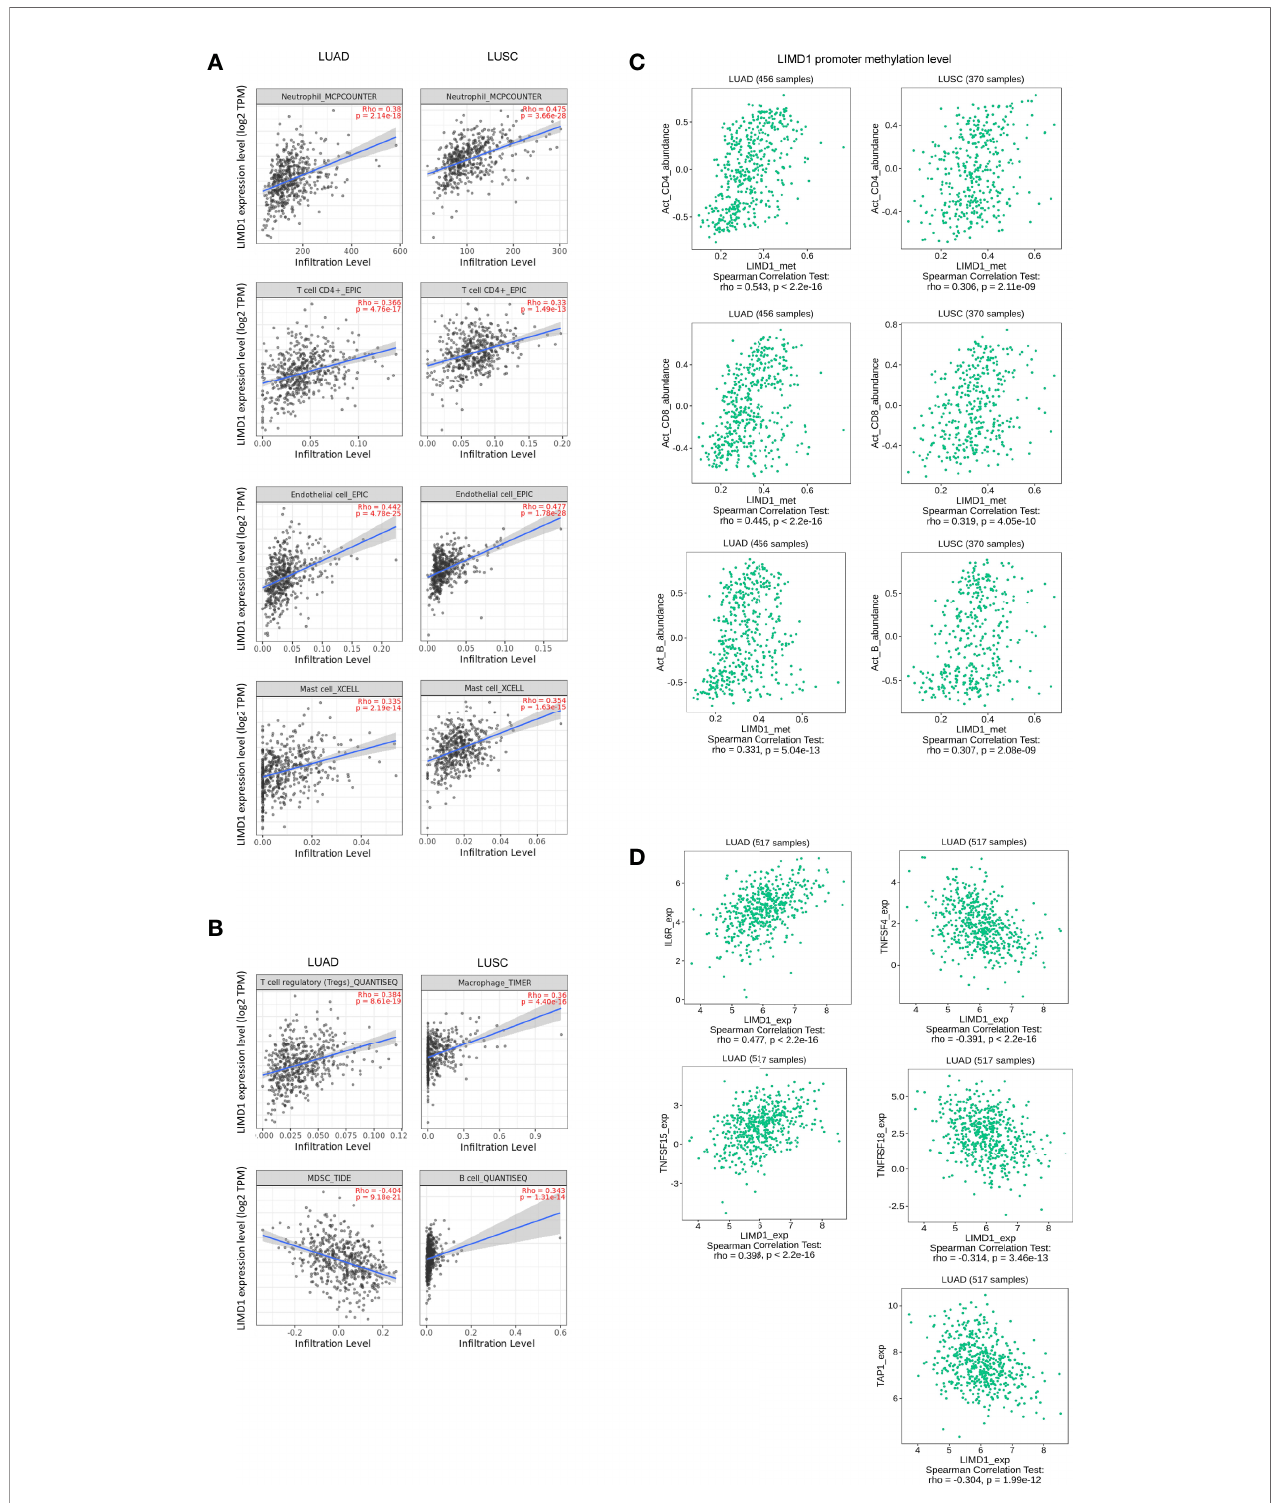
FIGURE 6 | LIMD1 correlates with immune in fi ltration in NSCLC. (A, B) LIMD1 expression signi fi cantly correlates with a subgroup of immune in fi ltrating lymphocytes in LUAD and LUSC. (C) Methylation of the Limd1 gene promoter signi fi cantly correlates with immune in fi ltration. (D) LIMD1 expression signi fi cantly correlates with a subset of immune regulatory molecules in LUAD. (A, B) are the results from TIMER2, and (C, D) from